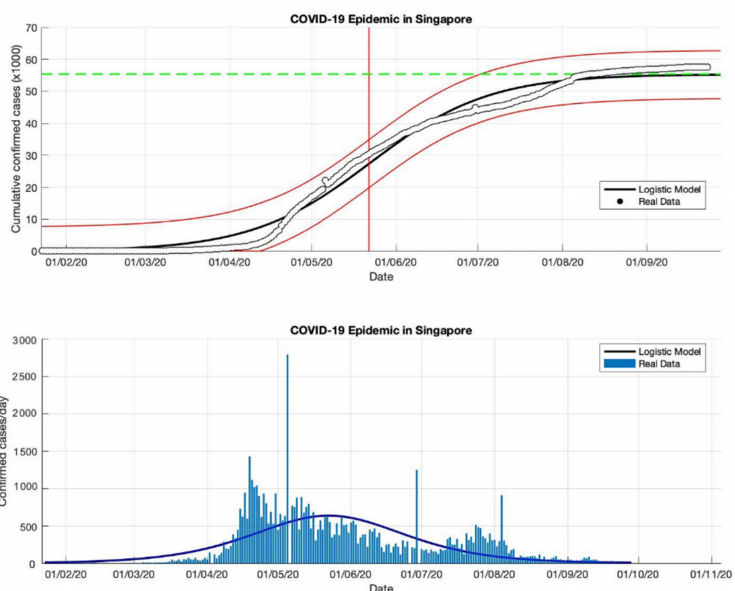
Figure 6. In the above figure, the prediction results of the logistic growth model for cumulative infected cases are compared with the actual data, while the two red lines between the black lines represent a prediction error limit of about 5%. The dashed green line predicts the total size of infected cases in the final phase of the epidemic. The red line intersects the cumulative case curve to predict the turning point or peak point of the epidemic (this line is parallel to the top of the curve from the below figure). In the below figure, the prediction results of this model for daily infected cases in